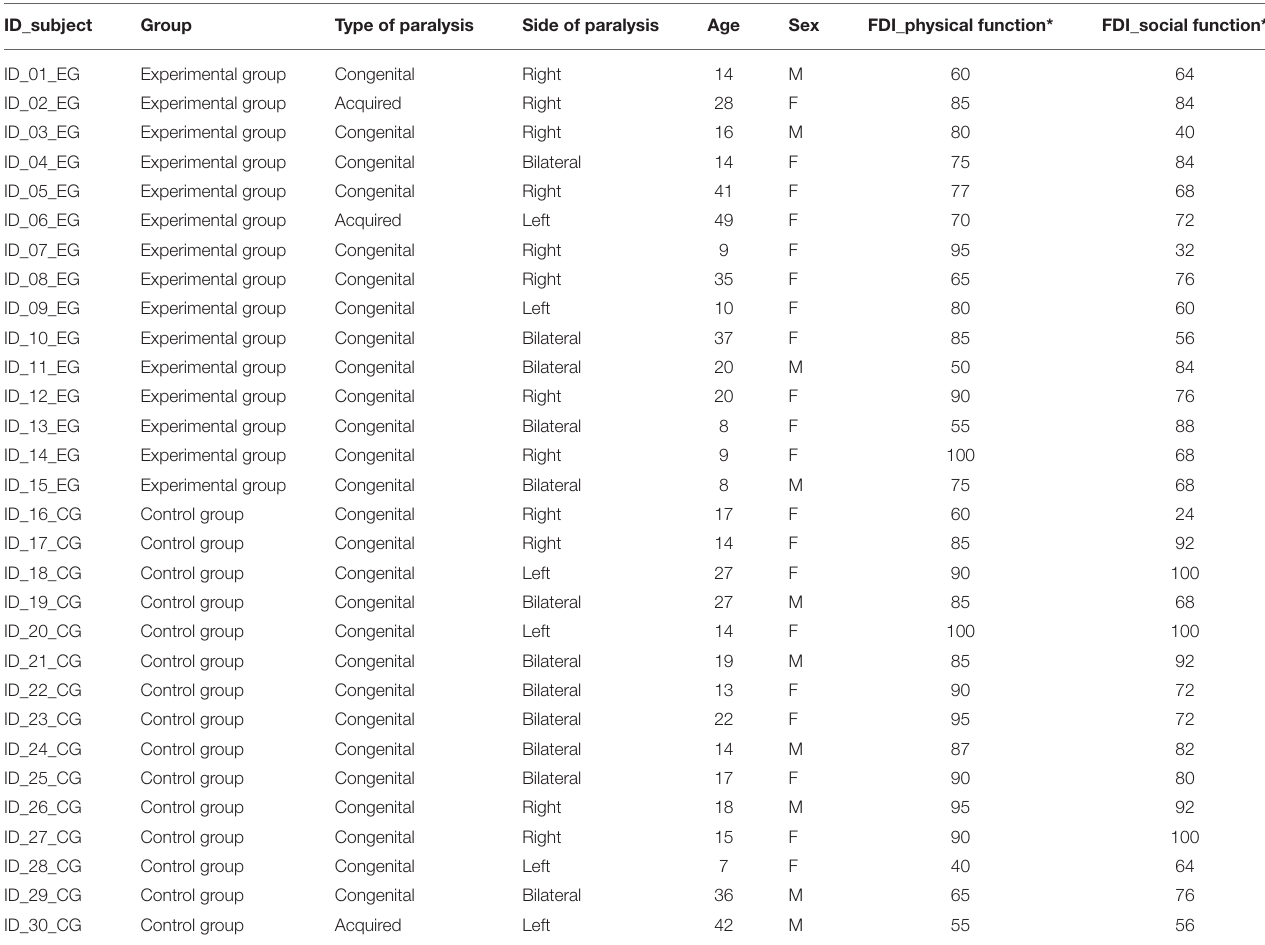
* Scores of physical and social subscales are reported transformed to a score on a 100-point scale. A value 100 indicates unimpaired physical or social/wellbeing function